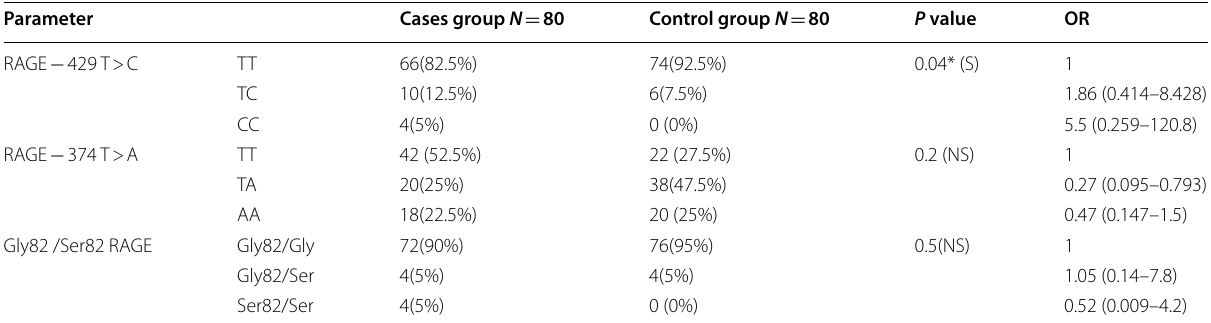
Table 3 Distribution of studied groups according to RAGE ( between HT cases and control regardingdistribution of single nucleotide polymorphism (SNP) of -427 T>C gene and shows nonsignificantdifferences regarding -347T>A and Gly 82 ser.